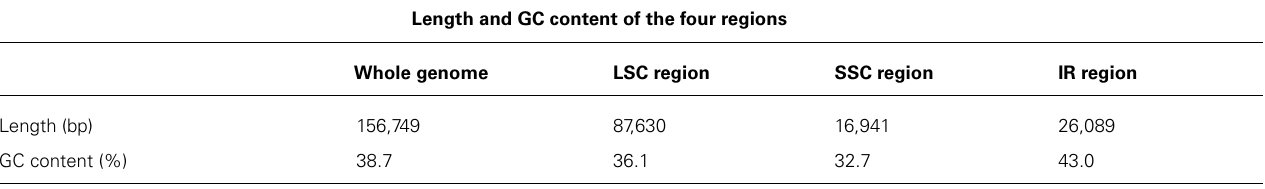
Table 2 | General information of the Aconitum barbatum var. puberulum chloroplast genome.